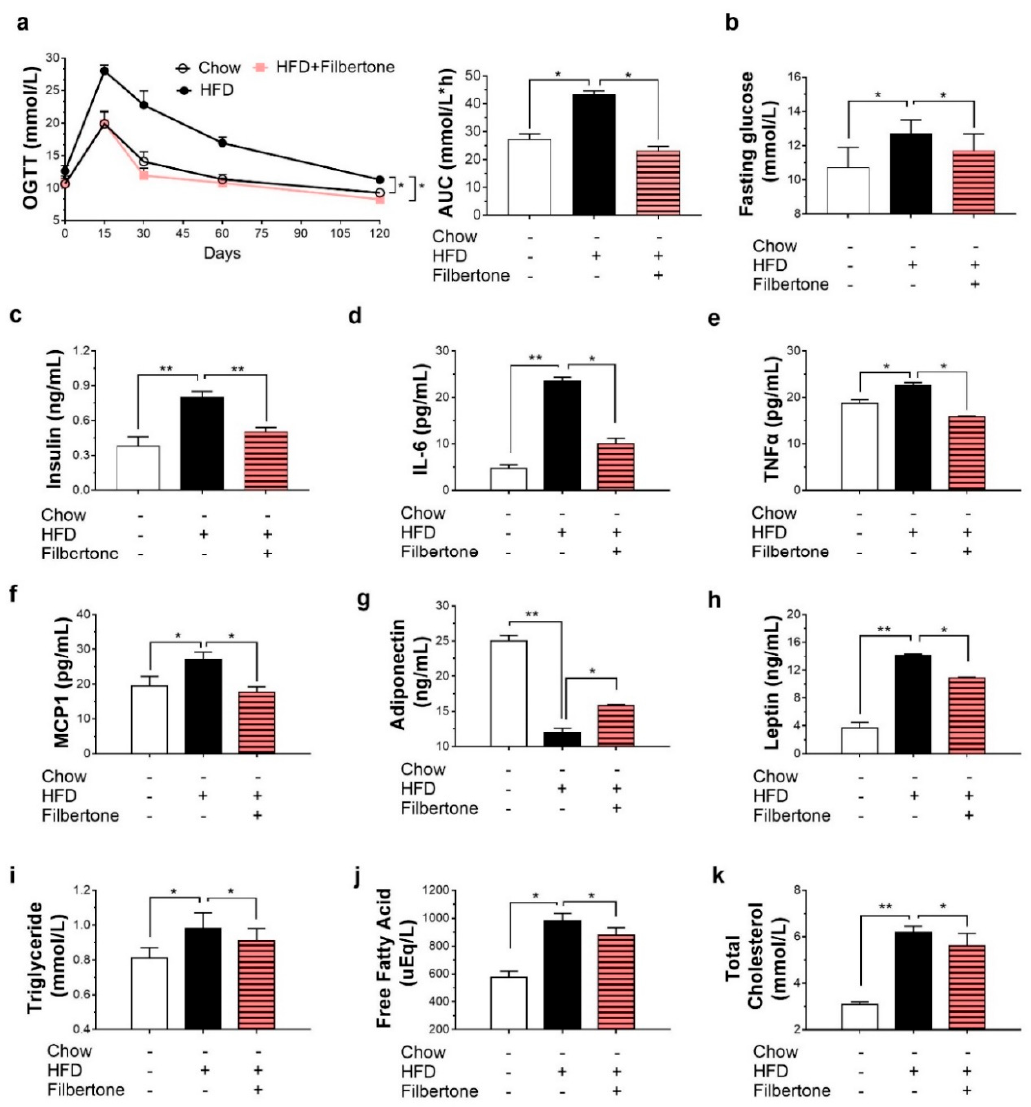
Figure 2. Mouse plasma biochemical parameters. ( a ) Oral glucose tolerance test (OGTT) and area under the curve (AUC); fasting plasma levels of ( b ) glucose and ( c ) insulin index; plasma levels of the proinflammatory cytokines ( d ) interleukin 6 (IL-6), ( e ) tumor necrosis factor alpha (TNF- α ), ( f ) monocyte chemoattractant protein 1 (MCP1), ( g ) adiponectin, and ( h ) leptin. Plasma levels of ( i ) triglycerides, ( j ) free fatty acids (FFAs), and ( k ) total cholesterol * p < 0.05, ** p < 0.01, and *** p < 0.001, between the groups. Values are means ± SEM.